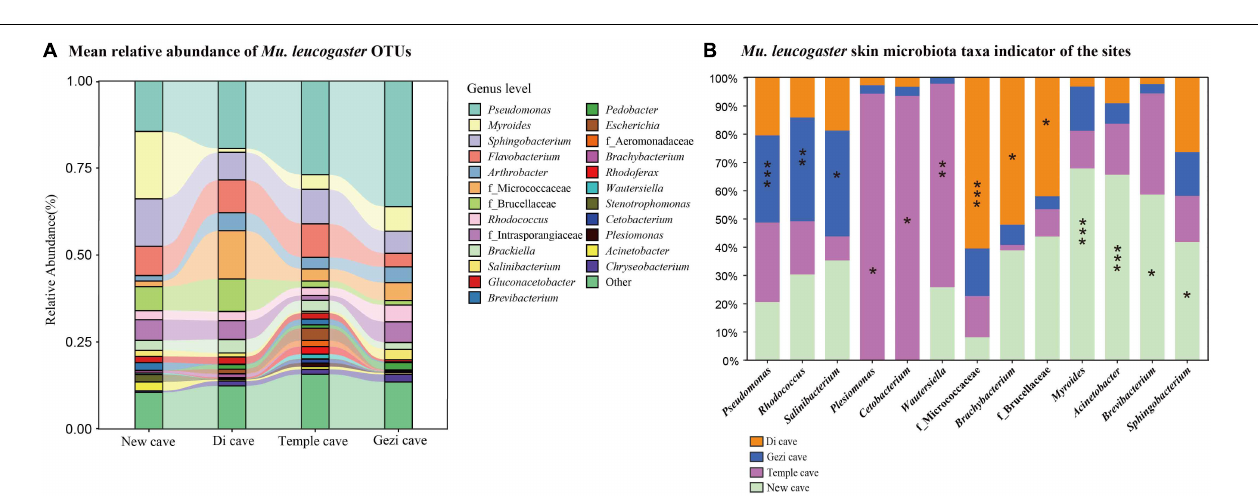
FIGURE 4 | Skin bacterial community composition of Mu. leucogaster . (A) Alluvial diagram of mean relative abundances of bacterial taxa (genus level) of Mu. leucogaster across sites. The relative abundances of bacterial genera > 1%. (B) Mu. leucogaster skin microbiota taxa indicator of the sites. Significant indicators were found among the 13 most abundant taxa representing more than 1% of total abundance with IndVal analysis. Stars indicate significant representative taxa. * P < 0.05, ** P < 0.01, *** P < 0.001, IndVal ≥ 0.4.